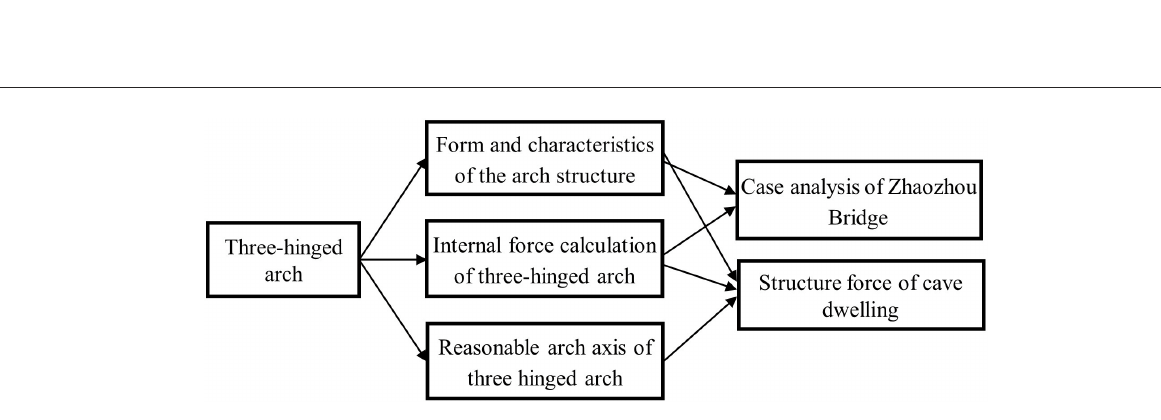
FIGURE4 The relationship diagram between the three-hinged arch knowledge module, knowledge points and case